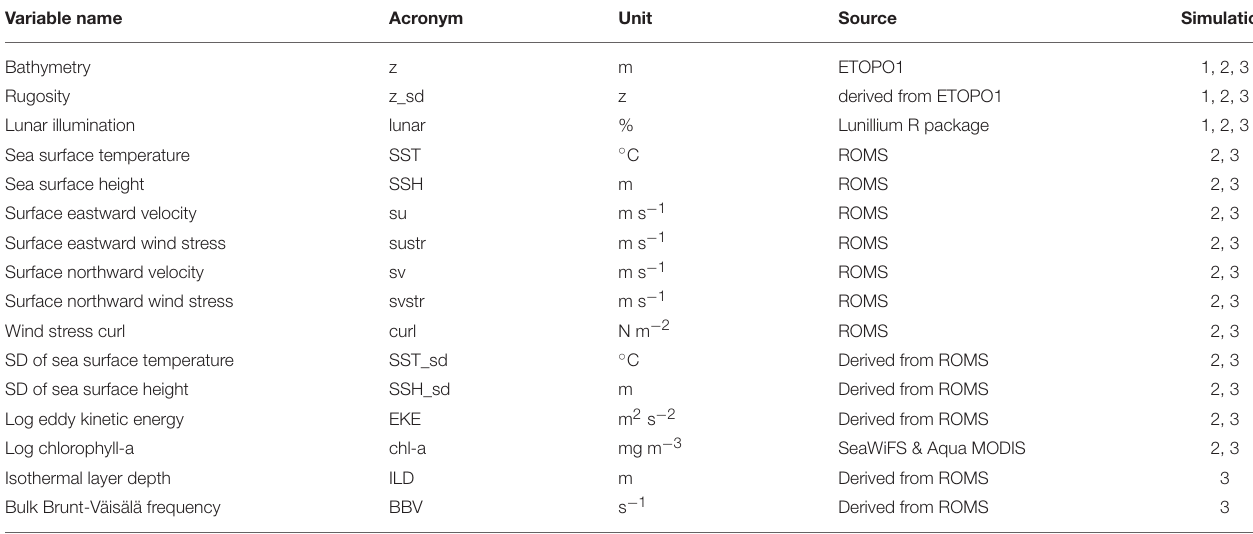
TABLE 2 | Summary of 16 environmental variables included in species distribution